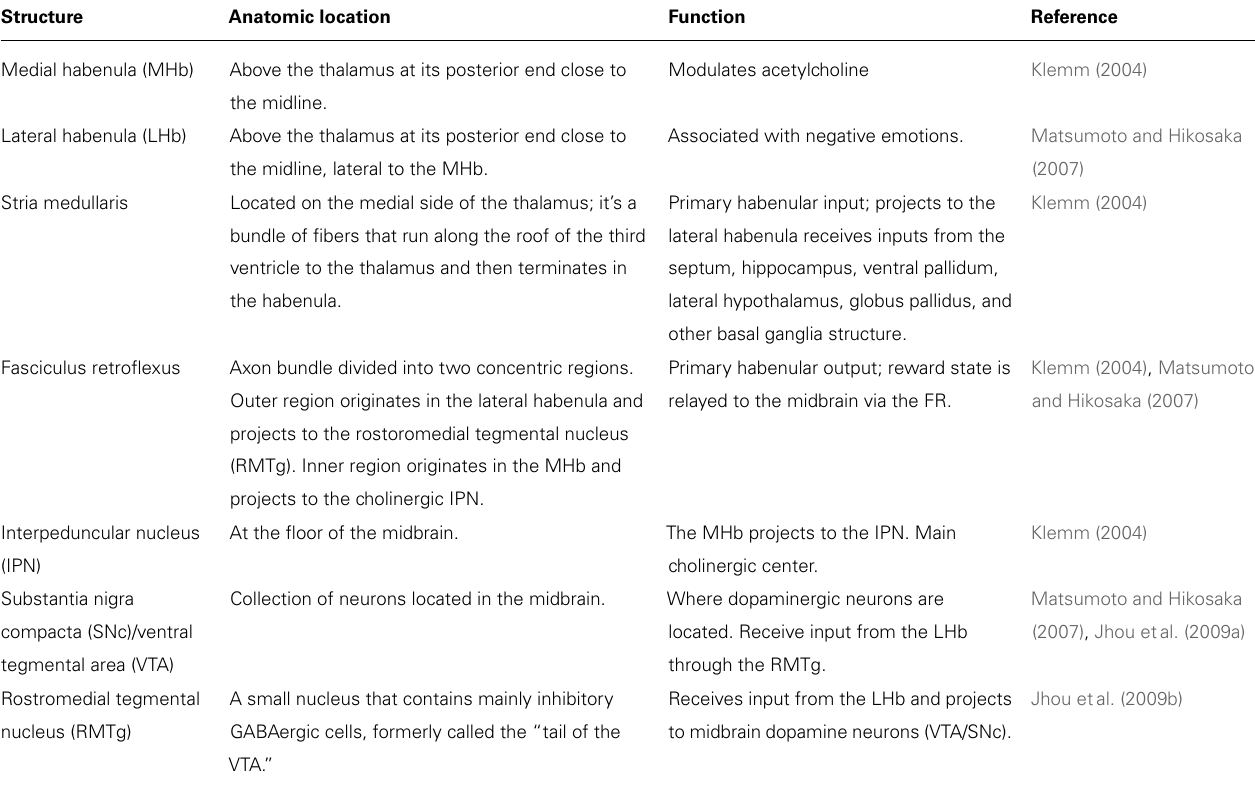
Table 1 |The function and anatomic location of brain structures associated with the habenula.